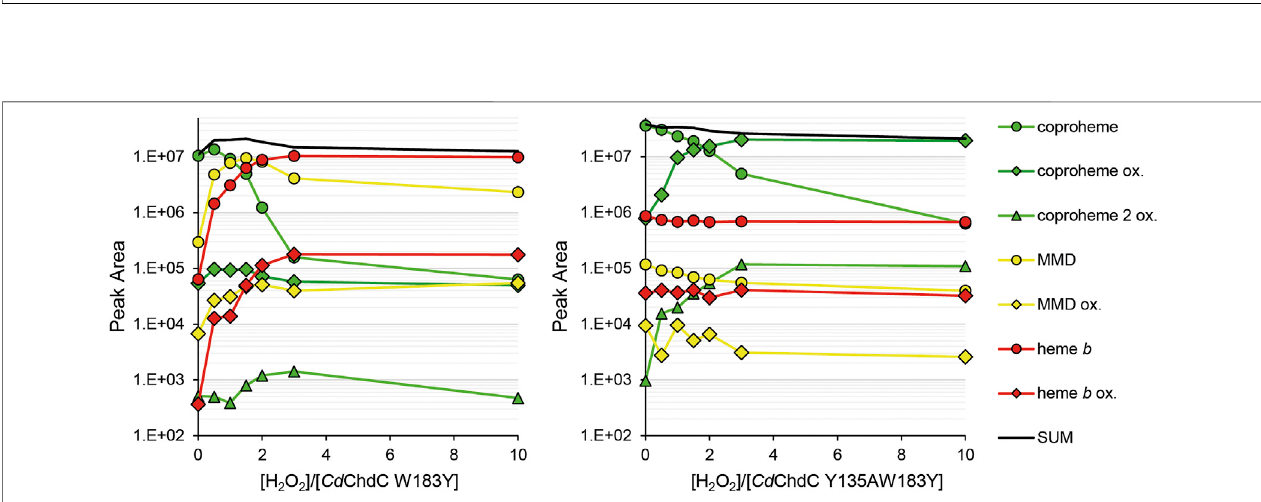
Frontiers in Bioengineering and Biotechnology |